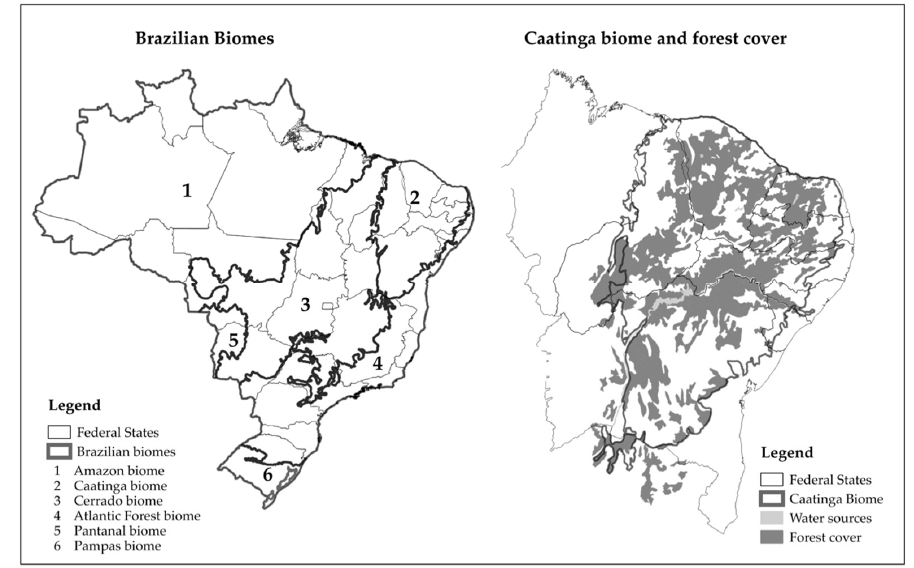
Figure 1. Brazilian biomes and forest cover in Caatinga biome (Elaborated by the author cf. [19,20]).